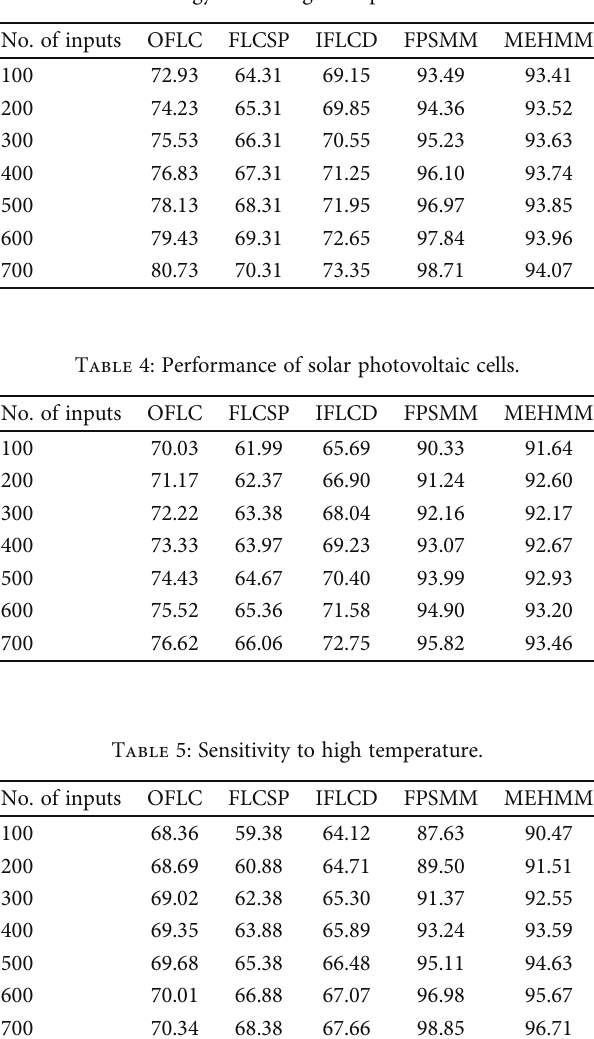
Table 3: Energy harvesting solar photovoltaic cells.